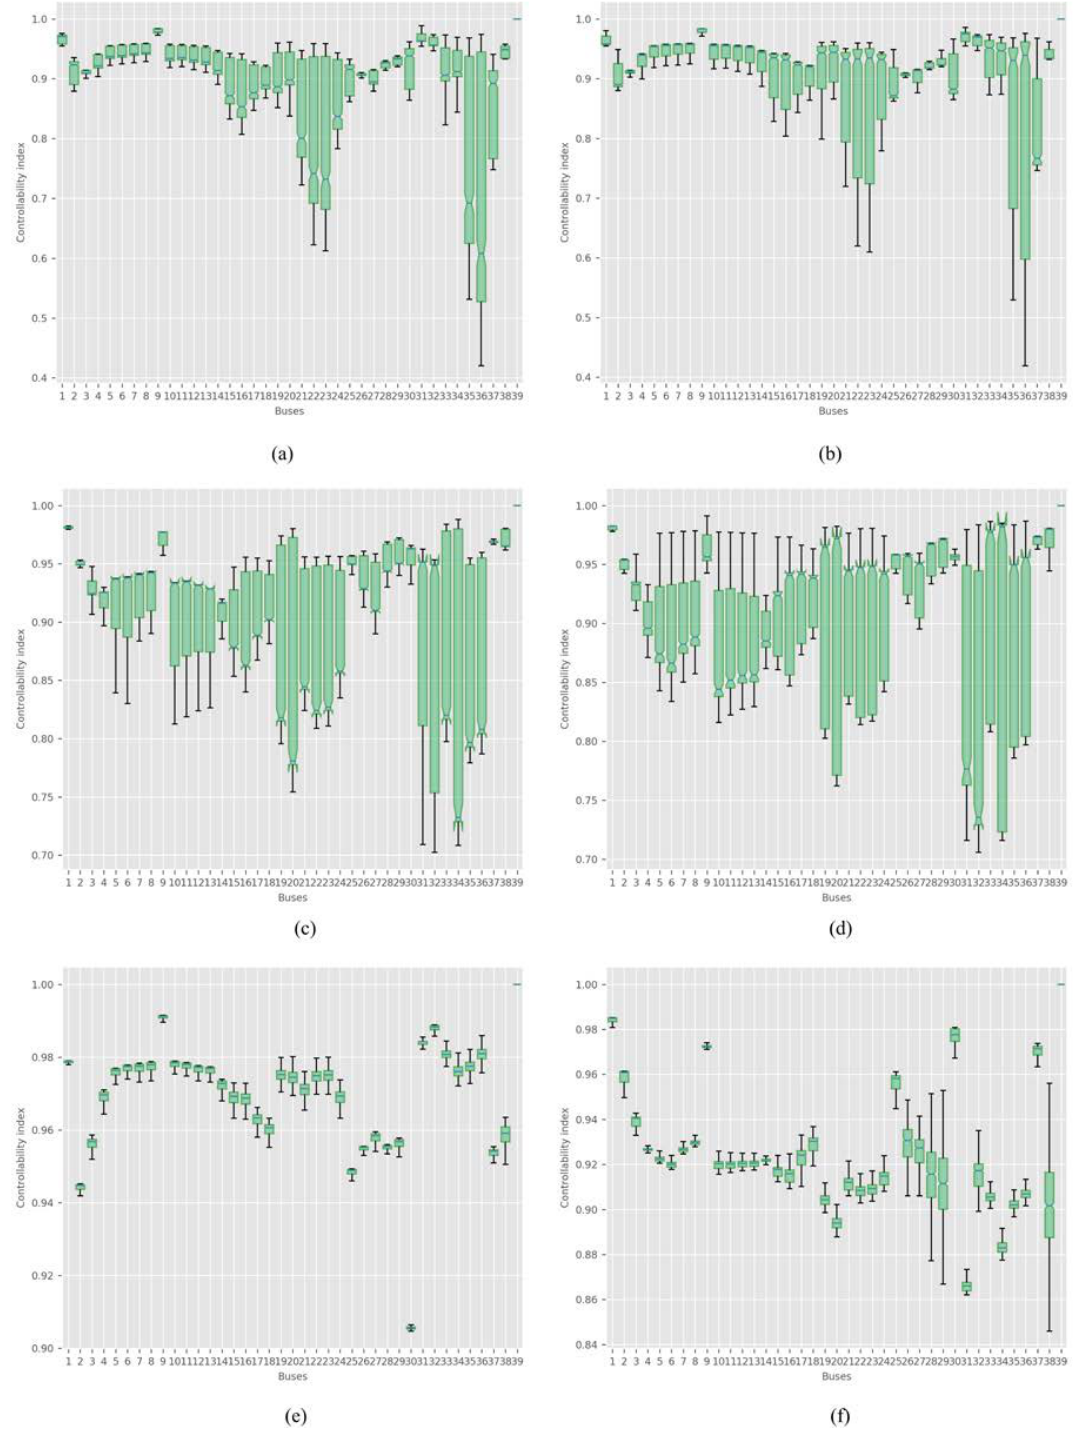
Figure 4. Box plot of controllability index of LFO modes. ( a ) OM3; ( b ) OM4; ( c ) OM5; ( d ) OM6; ( e ) OM7; ( f ) OM8.